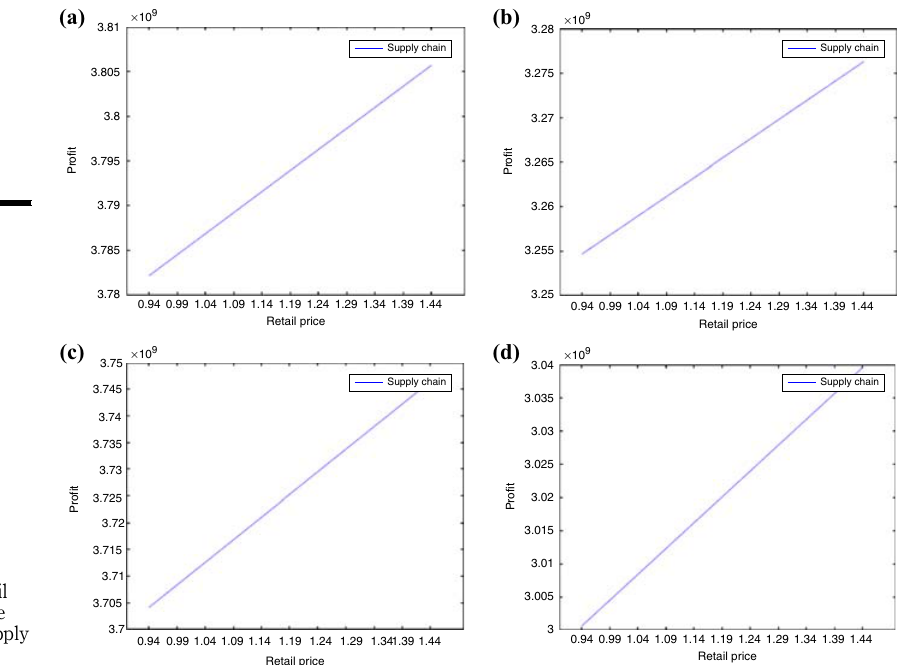
Figure 4. The impact of retail price change on the profit of IBWT supply chain without/with fairness concern